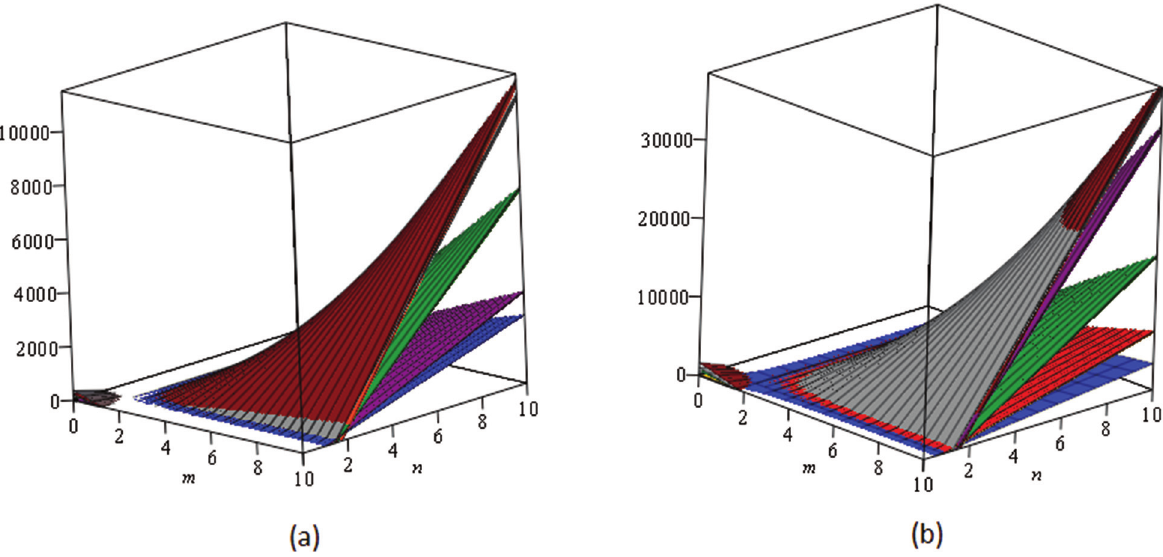
θ are labbled in blue, red, purple, green, orange, gray and θ , ZC ( ) θ , and ZC ( ) ( θ ), M ( θ ), ZC ( θ ), ZC ( θ ), ZC ( ) 1 1 2 1 1 1 2 1 3 1 1 1 2 1 θ , and ZC ( ) θ , ZC ( ) ( θ ), M ( θ ), ZC ( θ ), ZC ( θ ), ZC ( ) 1 2 2 2 1 2 2 2 2 2 1 2